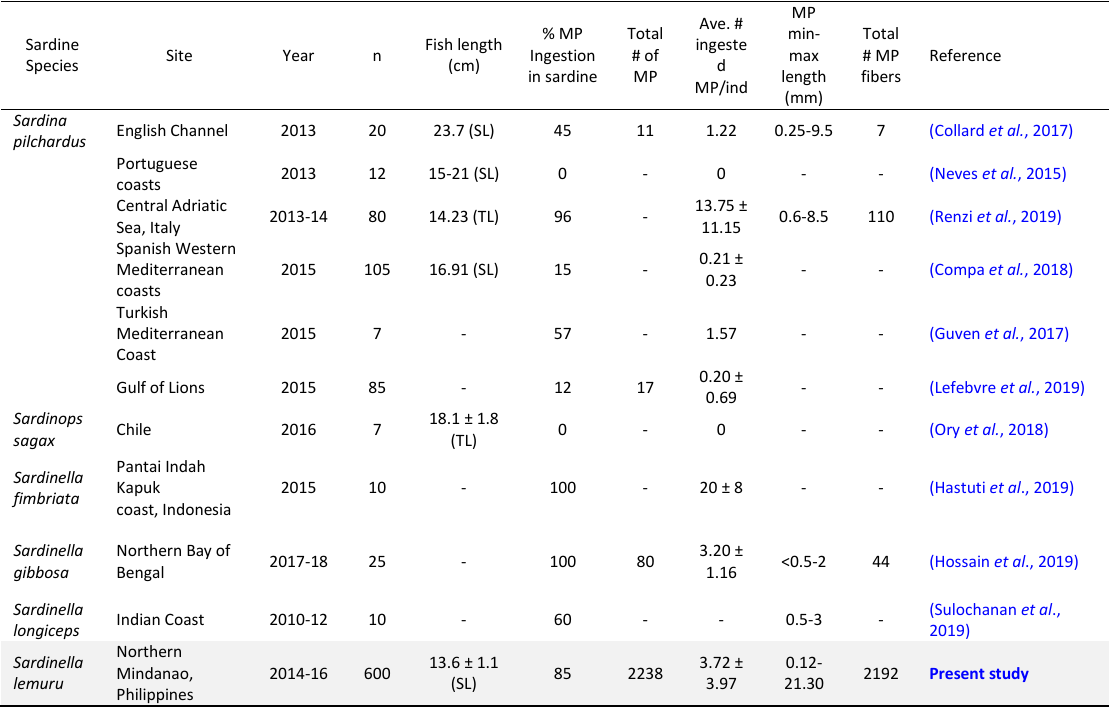
deviation, (min-max) range